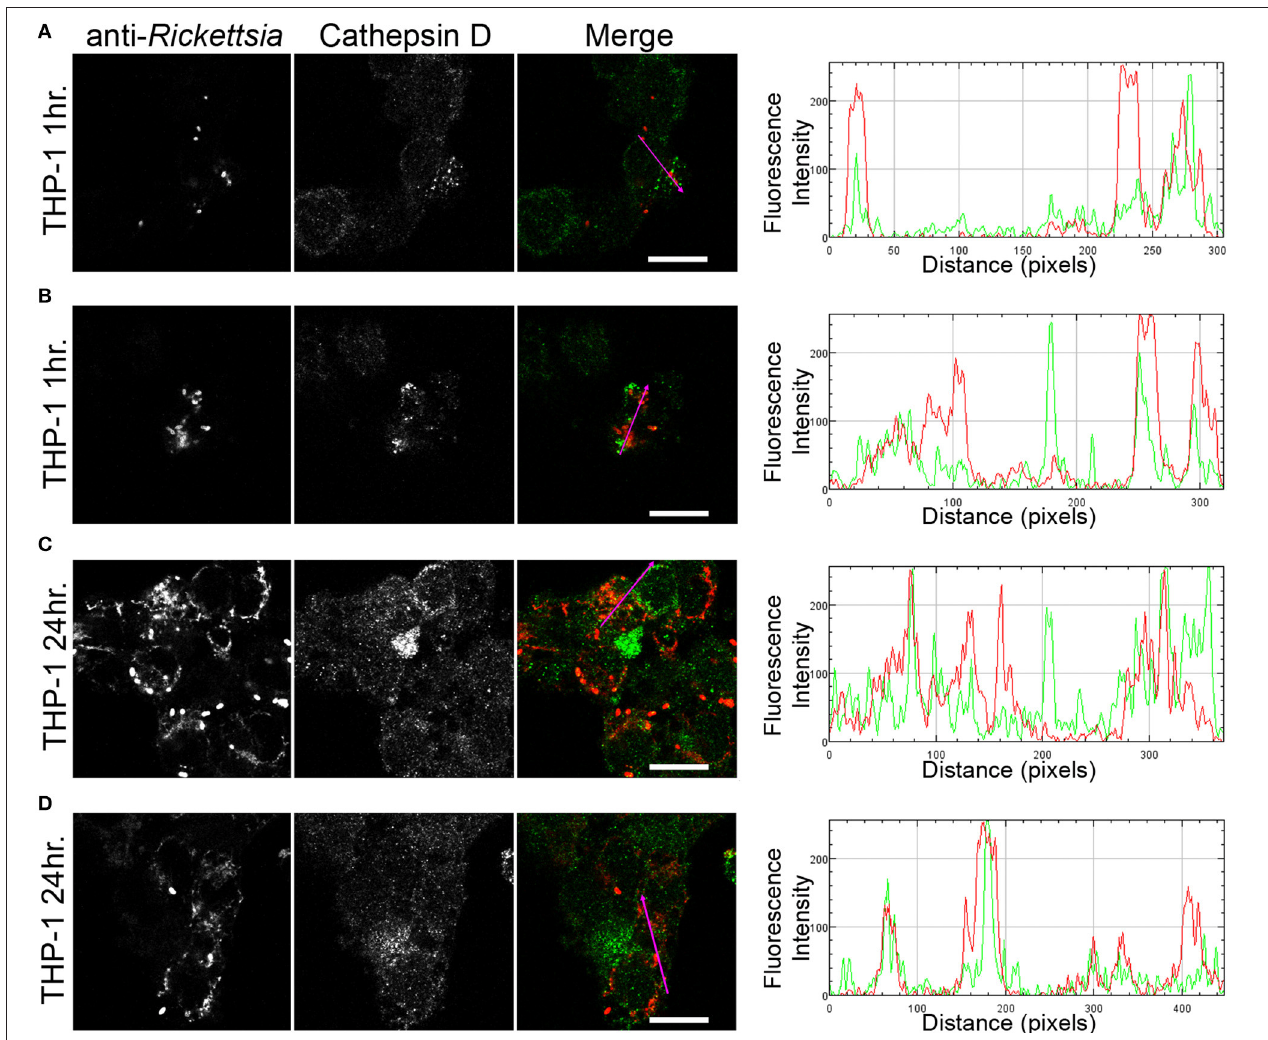
FIGURE 7 | R. montanensis co-localizes with the lysosomal marker cathepsin D. THP-1-derived macrophages were infected with R. montanensis (MOI = 10). At 60 min or 24 h post infection, cells were fixed, permeabilized, and double stained for immunofluorescence confocal microscopy analysis with NIH/RML I7198 followed by Alexa Fluor 546 (red) to stain R. montanensis , and the monoclonal antibody for cathepsin D followed by Alexa Fluor 488 (green). (A–D) Representative images of a single slice from the z stacks of THP1-derived macrophages at 60 min post infection (A,B) and 24 h post infection (C,D) . Each row shows, from left to right, Rickettsia staining, cathepsin D staining, the merged image, and a RGB plot profile illustrating the fluorescence intensity along the magenta arrow. Scale bar = 10 µ m. Supplementary Movies 9, 10 represent 360 ◦ rotation movie of the 3D projection of the stack images shown in (B) and (C) , respectively.